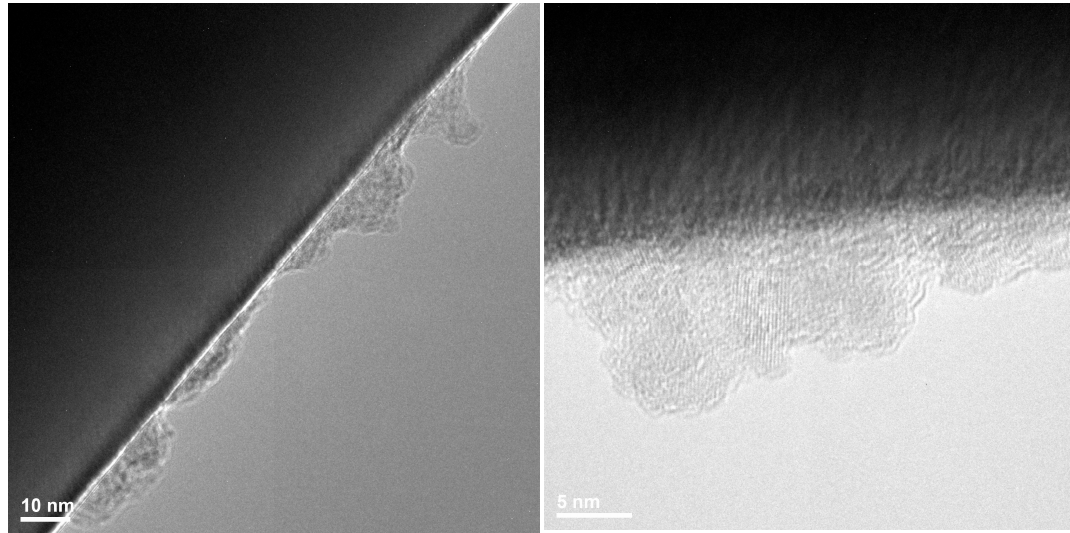
Figure 3. SEM images of coated wound dressing.